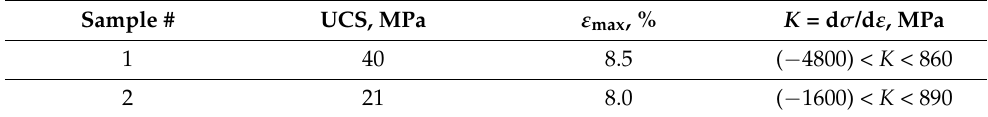
Figure 4. The monotonic compression “σ - ε” curve ( a ); the behavior of the “dσ/dε - ε” curve ( b ). Sample #1 (1) and Sample #2 (2) data are shown. Table 1. Mechanical properties of as-sintered porous segmented ceramics.